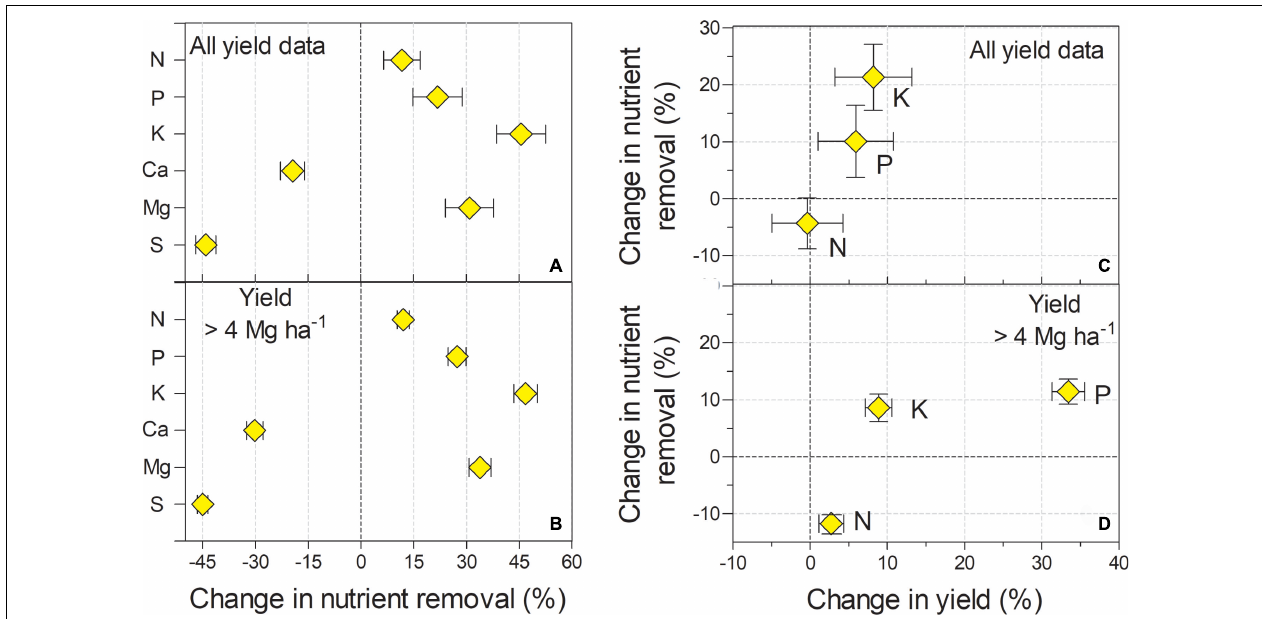
FIGURE 6 | Relative change in nutrient removal as a function of (A) relative yield and (B) relatively high yield for the current study and model built from historical values. (C) Relative change in nutrient removal (N, P, and K) as a function of relative yield and (D) relatively high yield for the current study and literature data. The vertical and horizontal bars indicate the standard error for the x and y variables,